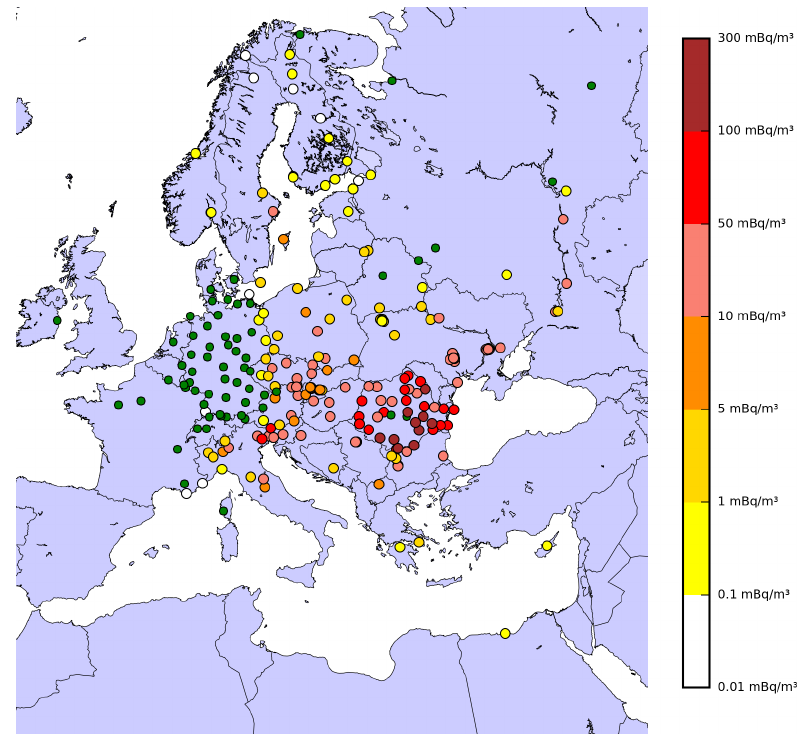
Figure 1. Maximum air concentrations of 106 Ru observed over Europe in mBqm − 3 . Green points measured concentrations below the detection limit.